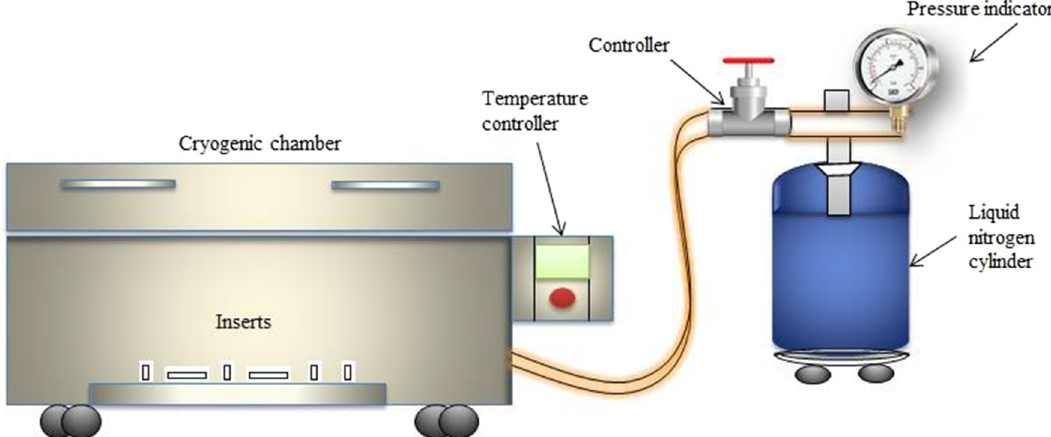
Fig. 2. A typical representation of cryogenic treatment